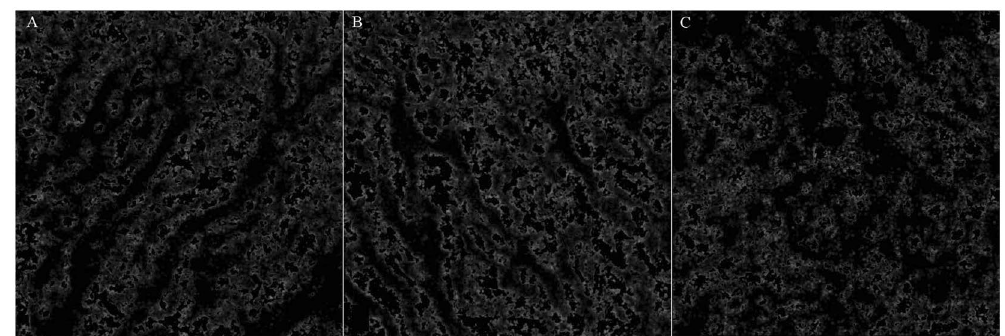
Figure 5. Choroidal blood flow image after removal of the projection artifacts of choriocapillaris using spectral domain optical coherence tomography angiography. Choroidal vessels are not visible in all eyes. Brightness and contrast are adjusted for easy understanding of these figures. ( A ) Case 1. Right eye of 35-year-old subject presented in Fig. 6. ( B ) Case 5 Left eye of (Fig. 1). ( C ) Case 8 Right eye (Fig.